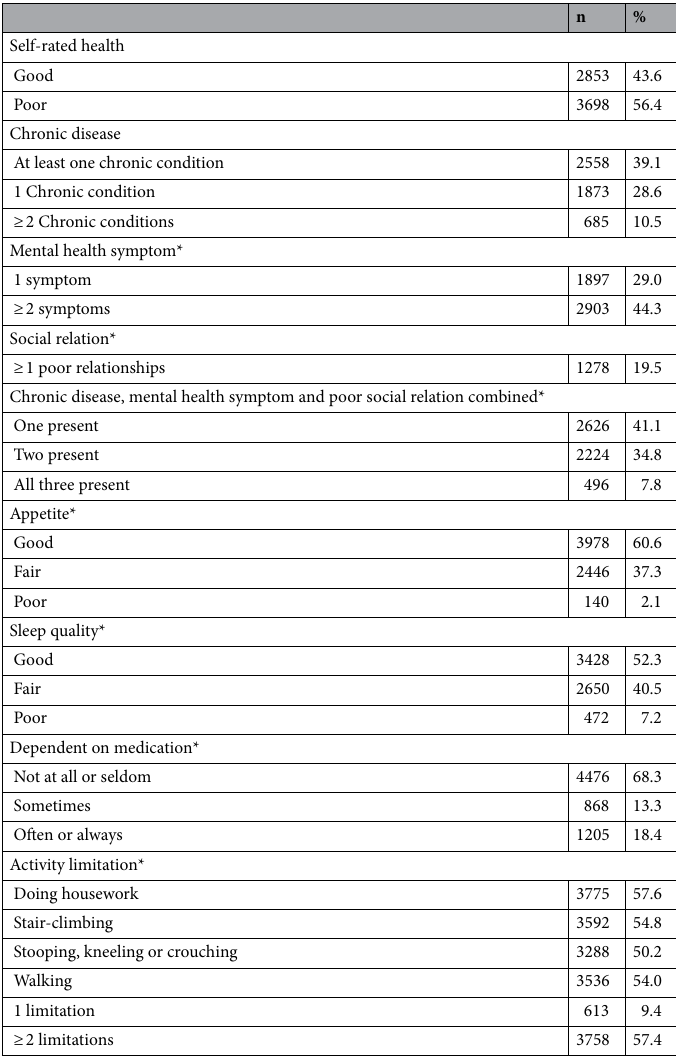
Figure 1 shows the number and proportion of participants with various physical diseases, psychological states, and social relationships. Hypertension (27.7%), poor memory (62.7%) and poor neighbor relationships (14.9%) were the most commonly reported problems. Association between self‑rated health and chronic disease, mental health symptoms, and poor social relationships. The bivariate analysis showed that, compared with participants who reported good self-rated health, those who reported poor self-rated health had a higher prevalence of chronic disease (52.8% vs. 21.2%, P < 0.001), mental health symptoms (87.9% vs. 58.5%, P < 0.001), poor social relationships (26.8% vs. 10.2%, P < 0.001), and the co-occurrence of chronic disease, mental health symptoms, and poor social relationships (12.4% vs. 1.7%, P < 0.001). Poor self-rated health was significantly associated with the three lead- ing chronic conditions (i.e., hypertension, diabetes and heart disease), mental health symptoms (feeling unsat- isfied with life, feeling low or depressed, poor memory and being unable to concentrate for 10 min) and poor social relationships (with family, friends, and neighbors) (Ps < 0.05) (Table 3). The logistic regression models, which included self-rated health (good vs. poor) as the dependent variable, demonstrated that poor self-rated health, after adjusting for other background characteristics, was significantly associated with chronic disease, mental health symptoms, and poor social relations (Ps < 0.05). The probability of poor self-rated health was higher among individuals with more than one chronic disease, mental health symptoms, and poor social relationships (odds ratio (OR): 4.27, 95% confidence interval (CI): 3.24–5.62; 2.75, 2.31–3.29; and 1.35, 1.13–1.62, respectively). In addition, poor economic conditions (OR 1.53; 95% CI: 1.30–1.79), poor housing conditions (1.78; 1.15–2.77), poor appetite (3.84; 1.82–8.12), poor sleep (1.95; 1.46–2.61), medica-